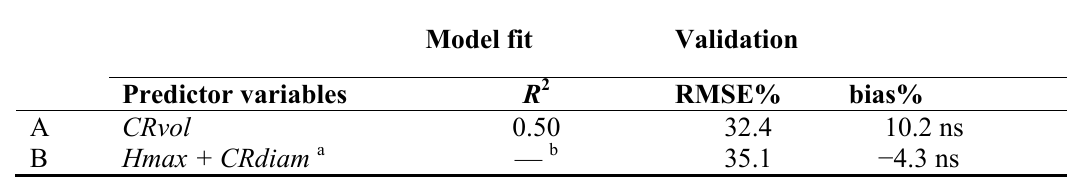
Table 4. Model and validation statistics for the ALS crown biomass model with the use of TLS when obtaining the training data (A) and crown biomass predictions obtained with ALS-predicted DBH and the use of an existing allometric model (B). R 2 from the model-fitting ( n = 68); root mean square error (RMSE)% and bias% from the validation ( n =